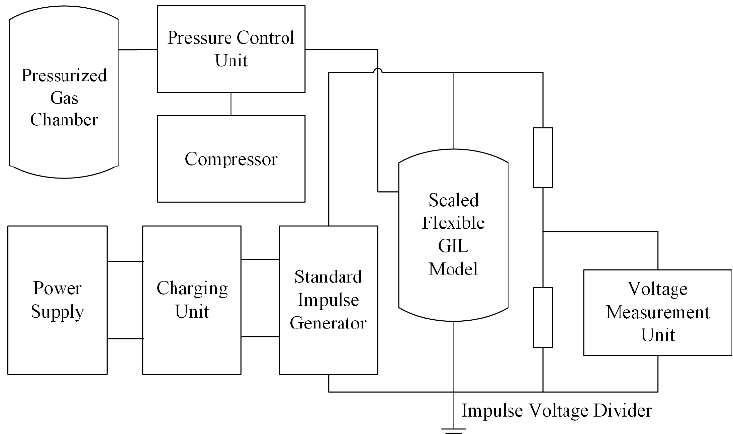
Figure 18. Experimental setup for the dielectric strength testing of the developed FGIL models.